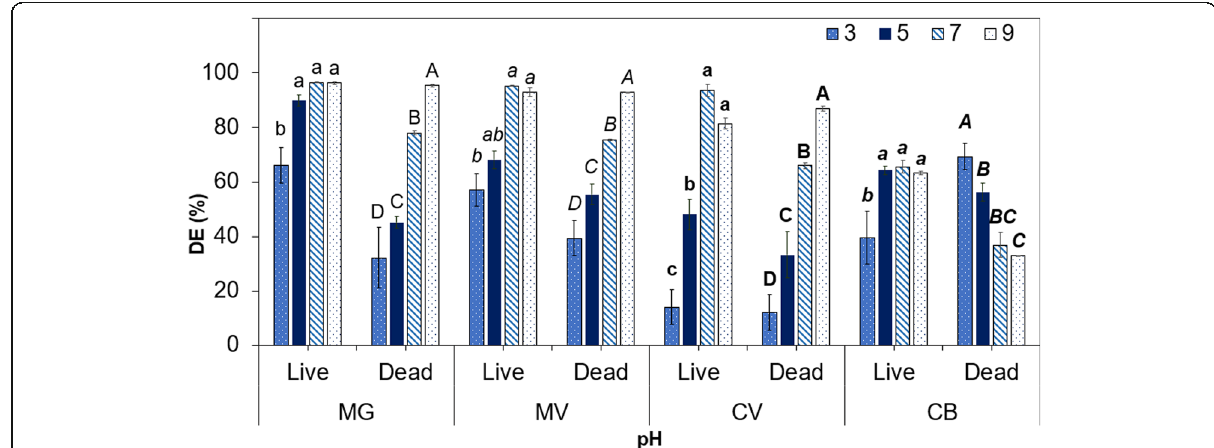
Fig. 4 Effect of pH on the DE of TPM dyes by Streptomyces isolate (live and dead cells). Means with the same letters (lowercase, live cells; uppercase, dead cells) and font style (MG, regular; MV, italic; CV, bold; CB, bold italic) are not significantly different at HSD ( 0.05 ). Bars indicate ±